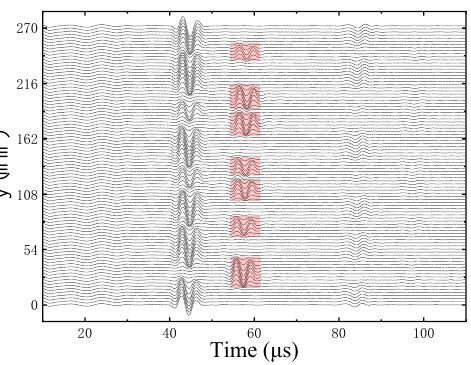
Figure 12. Measurement waveforms at the same height of grooved sandstone Plate 2.